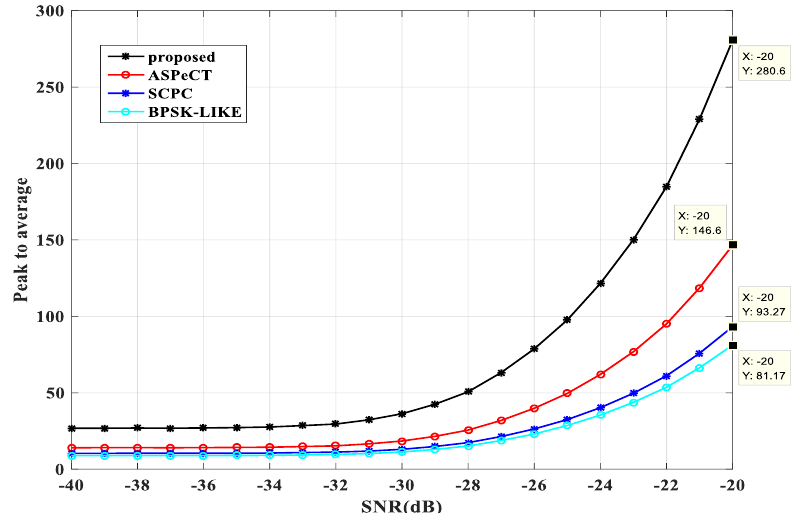
Figure 15. The peak to average ratio at M = 2.